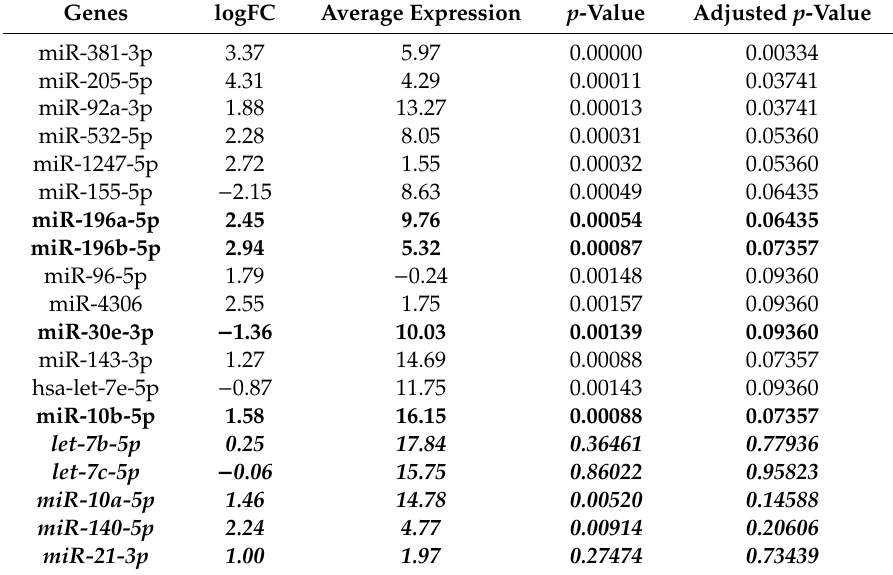
Table 5. MicroRNAs with the most significantly di ff erent levels in cerebrospinal fluid of low grade glioma patients in comparison to controls ( p < 0.01) supplemented with additional miRNAs tested in the validation phase of the study listed at the bottom of the table (in italics). All miRNAs selected for the validation phase are in bold; and logFC = binary logarithm of Fold Change.